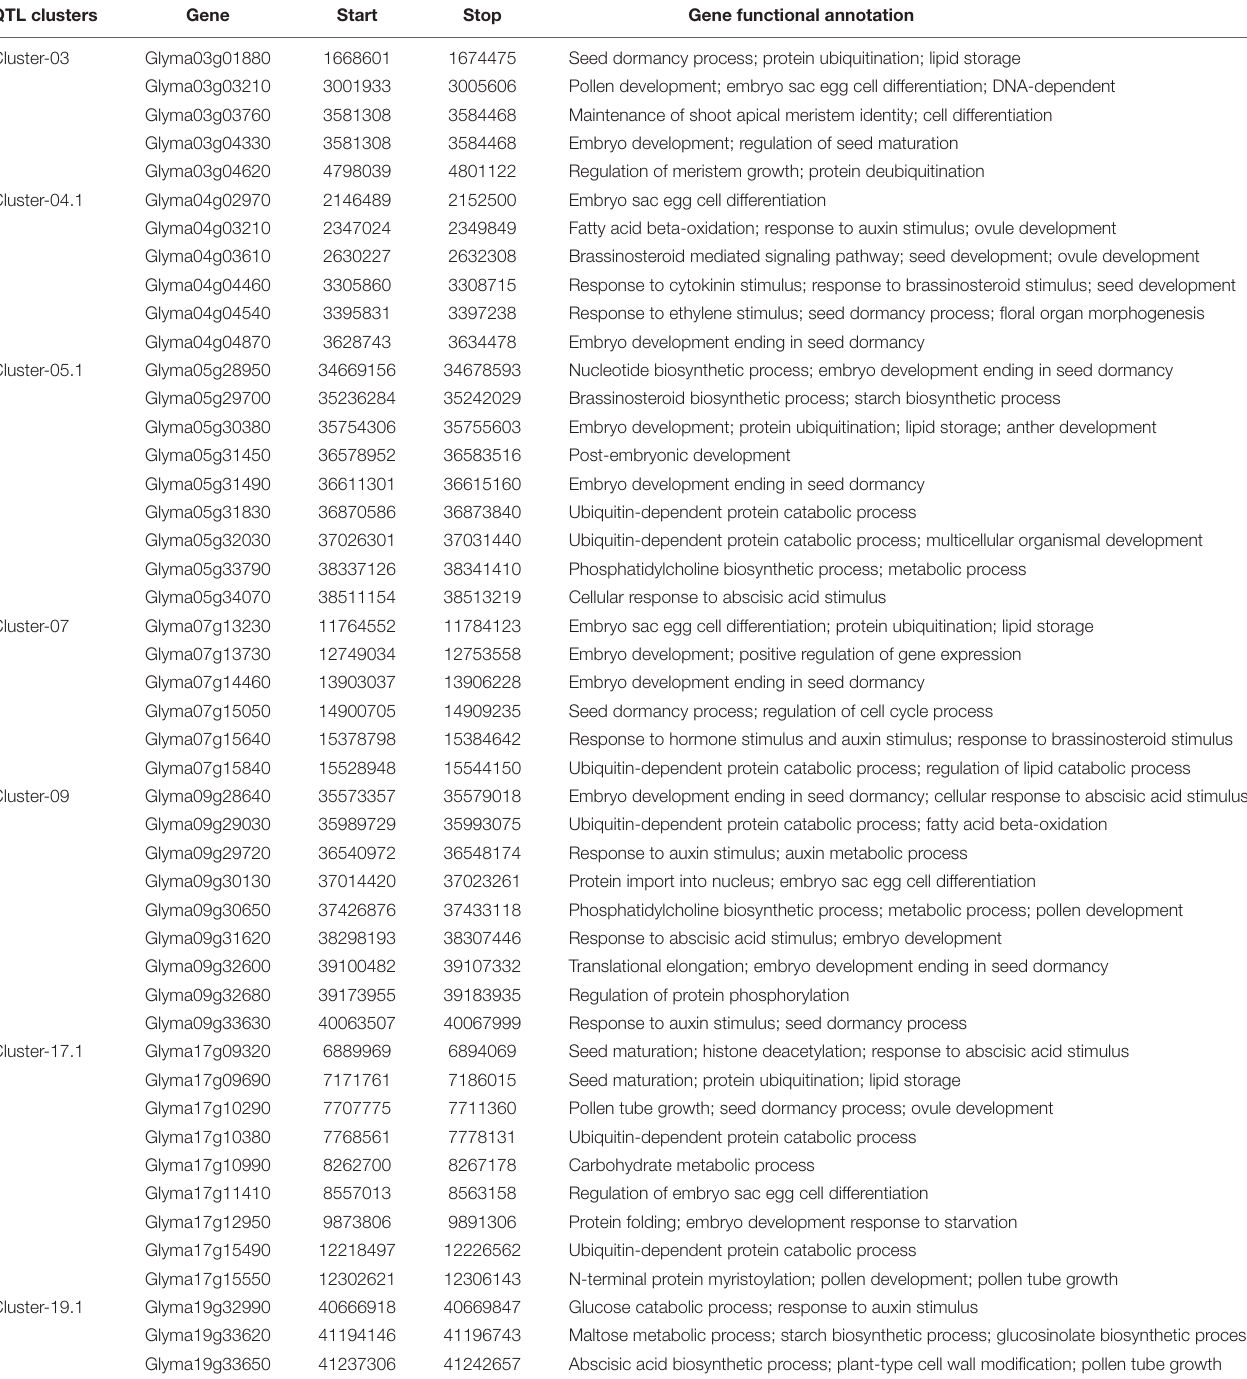
TABLE 5 | Candidate genes identified within the seven QTL clusters that are highly expressed in soybean seed. QTL clusters Gene Gene functional